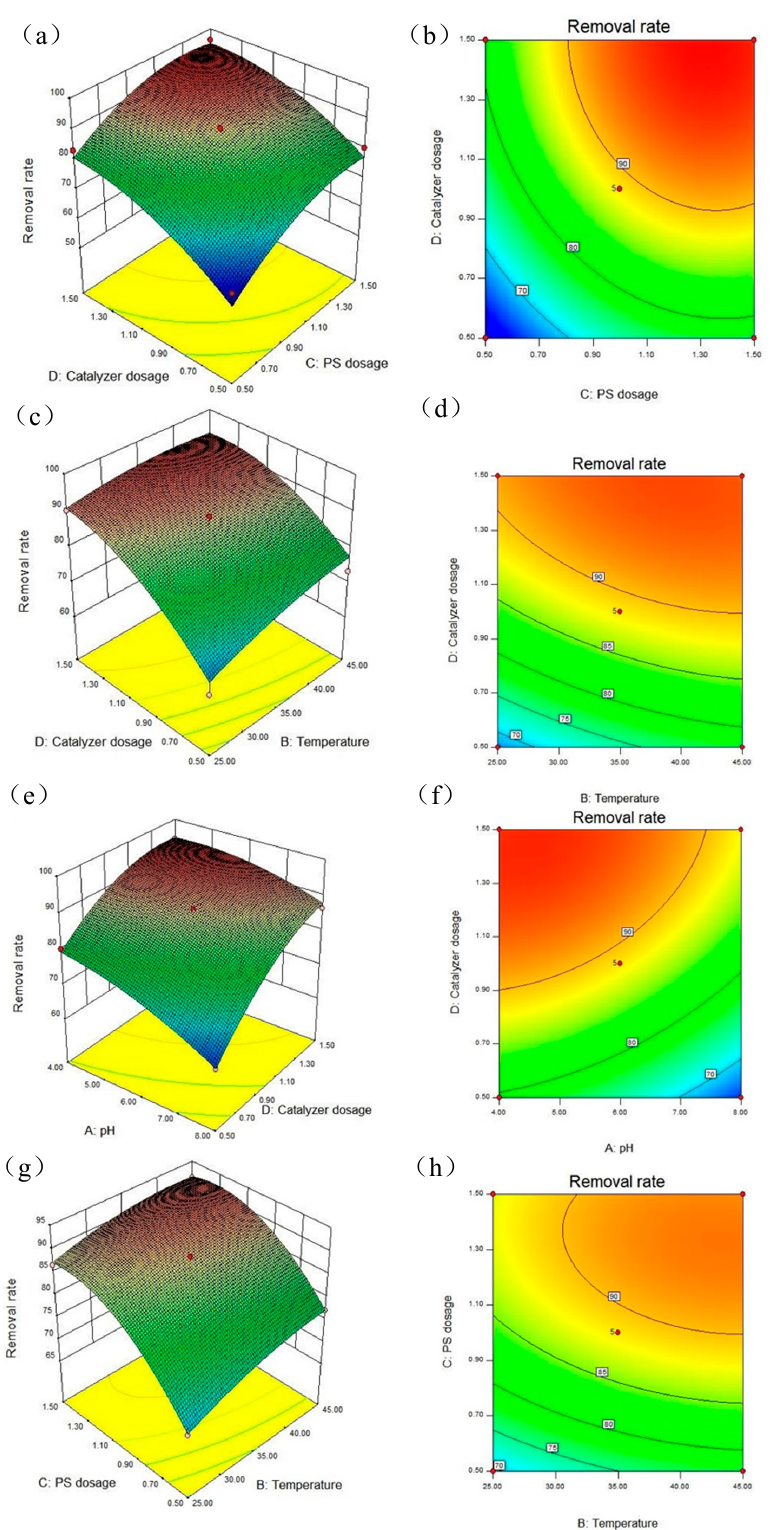
Figure 7. With regard to the LVF removal efficiency parameters, three-dimensional (3D) response surfaces and two-dimensional (2D) contours of Cu 2 Fe 2 O 4 / MMT-k10 dosage and PS dosage ( a , b ), Cu 2 Fe 2 O 4 / MMT-k10 dosage and temperature ( c , d ), Cu 2 Fe 2 O 4 / MMT-k10 dosage and pH value ( e , f ), and temperature and PS dosage ( g , h ) are